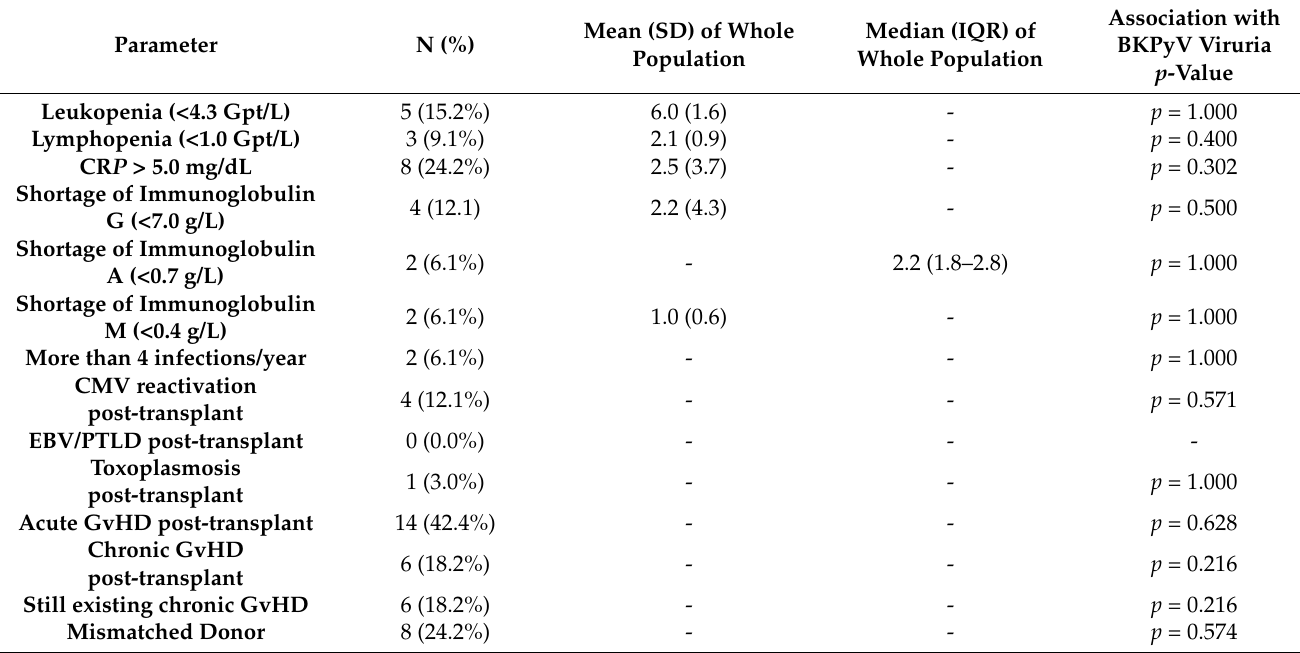
Table 3. Association of BKPyV viruria with immunological factors (n = 33).